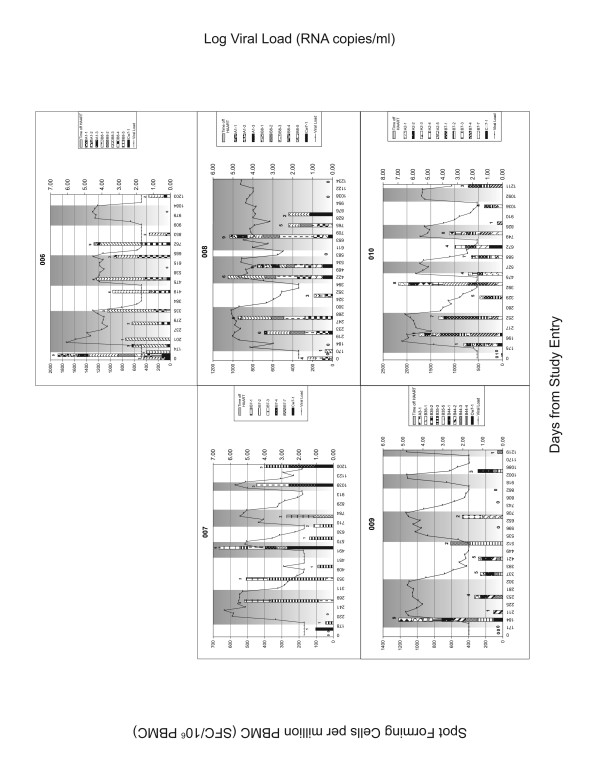
Results of IFN-γ ELISPOT assay for patient 006 to 010. See the legend for Figure 1.